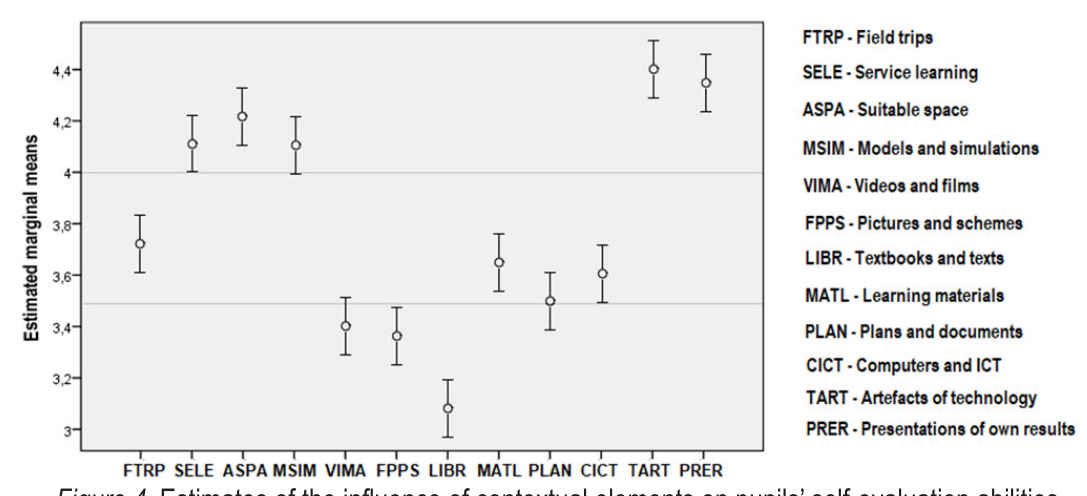
Figure 4. Estimates of the influence of contextual elements on pupils’ self-evaluation abilities